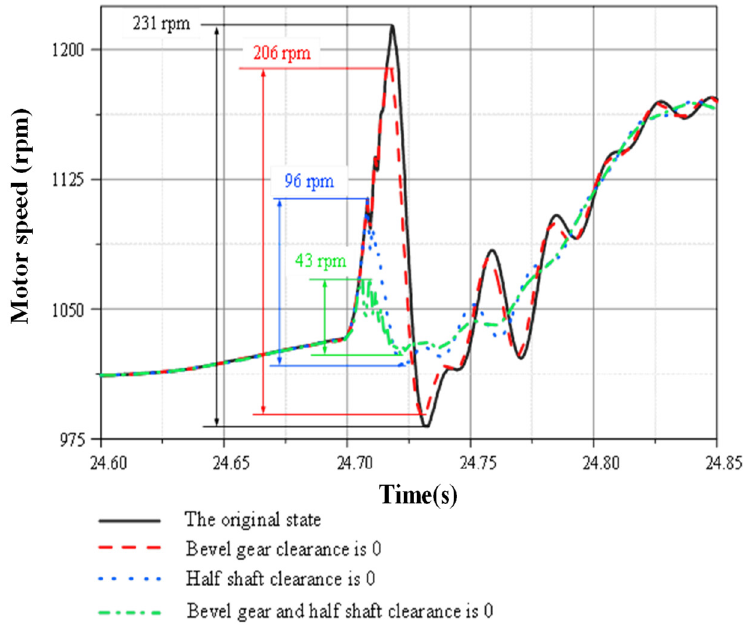
Figure 11. The changes in different gaps of low-speed e ngagement pairs.